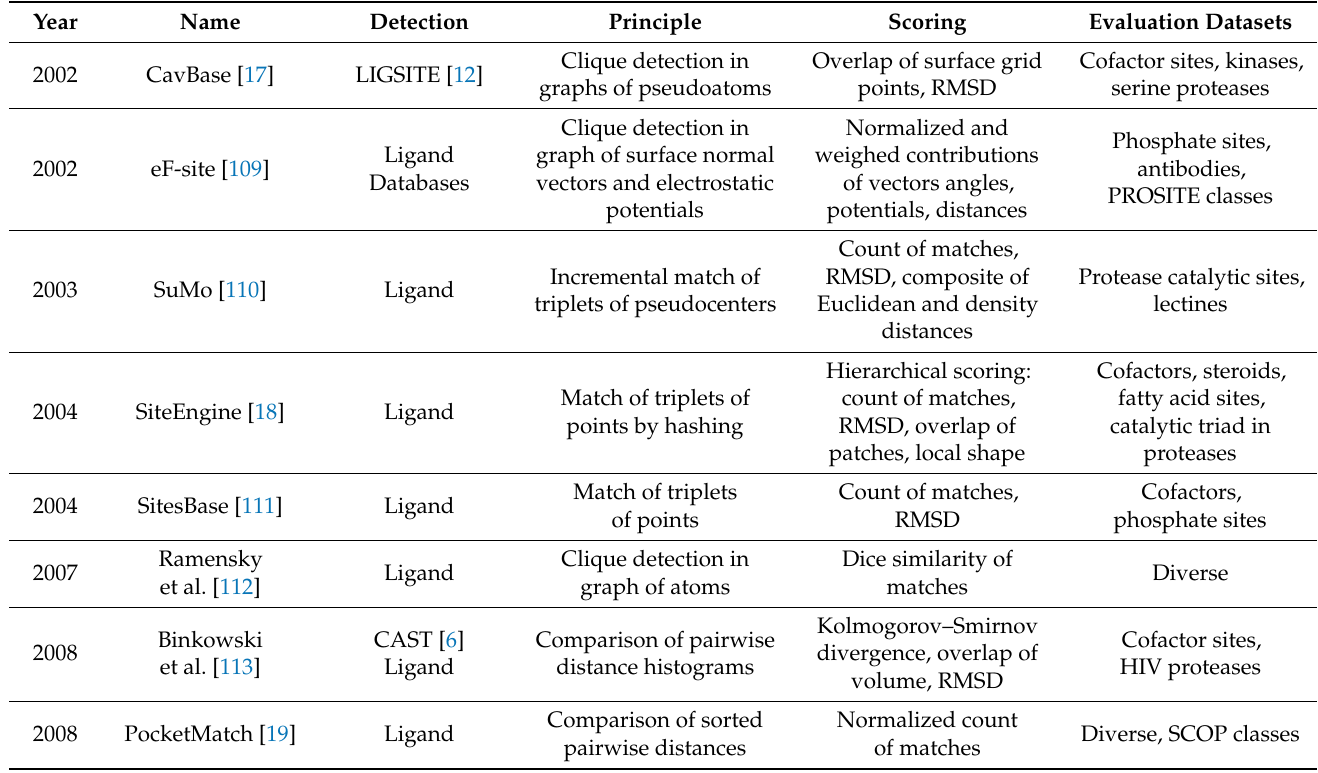
Table 2. Methods to compare protein